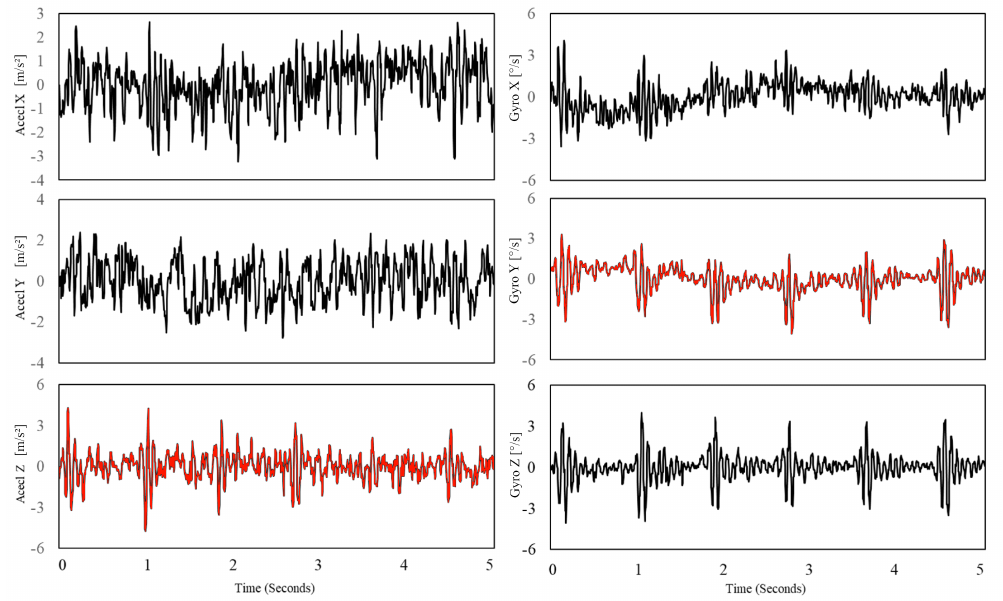
Figure 2. Raw SCG signal in three axes ( left ) and three orthogonal components of raw GCG signal ( right ). Typical axes of seismocardiogram (z-axis) and gyrocardiogram (y-axis) are shown as a red line. Modified version of the graph derived from the article [37] by Lee et al. under the license CC-BY 4.0.